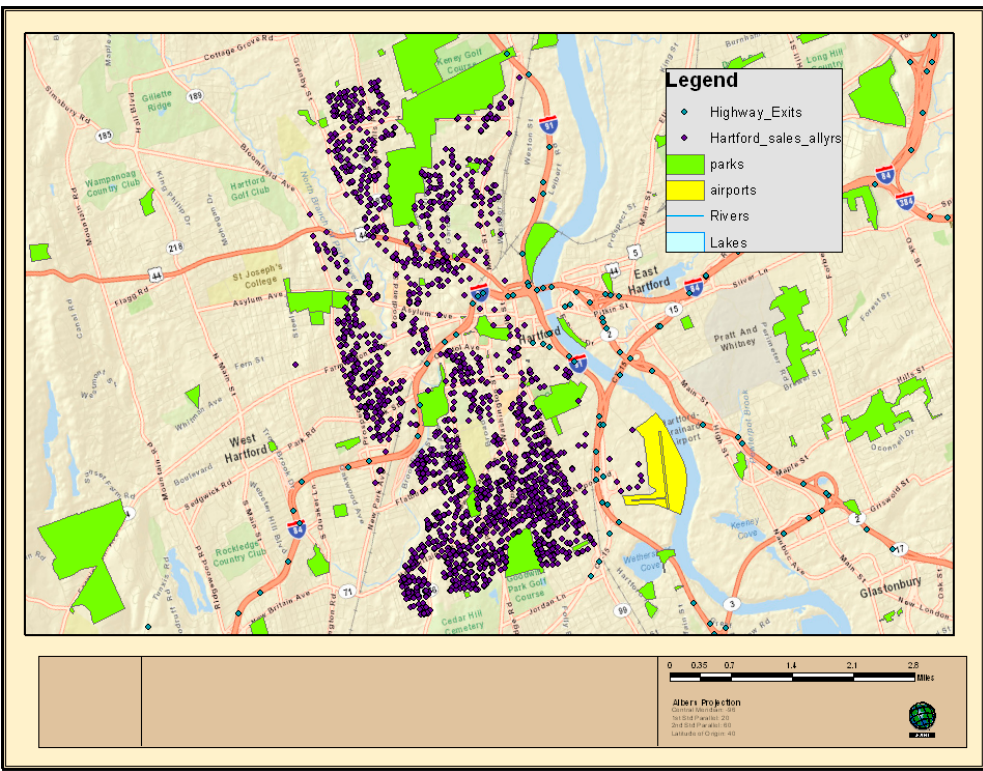
Figure 7. Property sales in Hartford, CT, for the tax years 2006 to 2010.